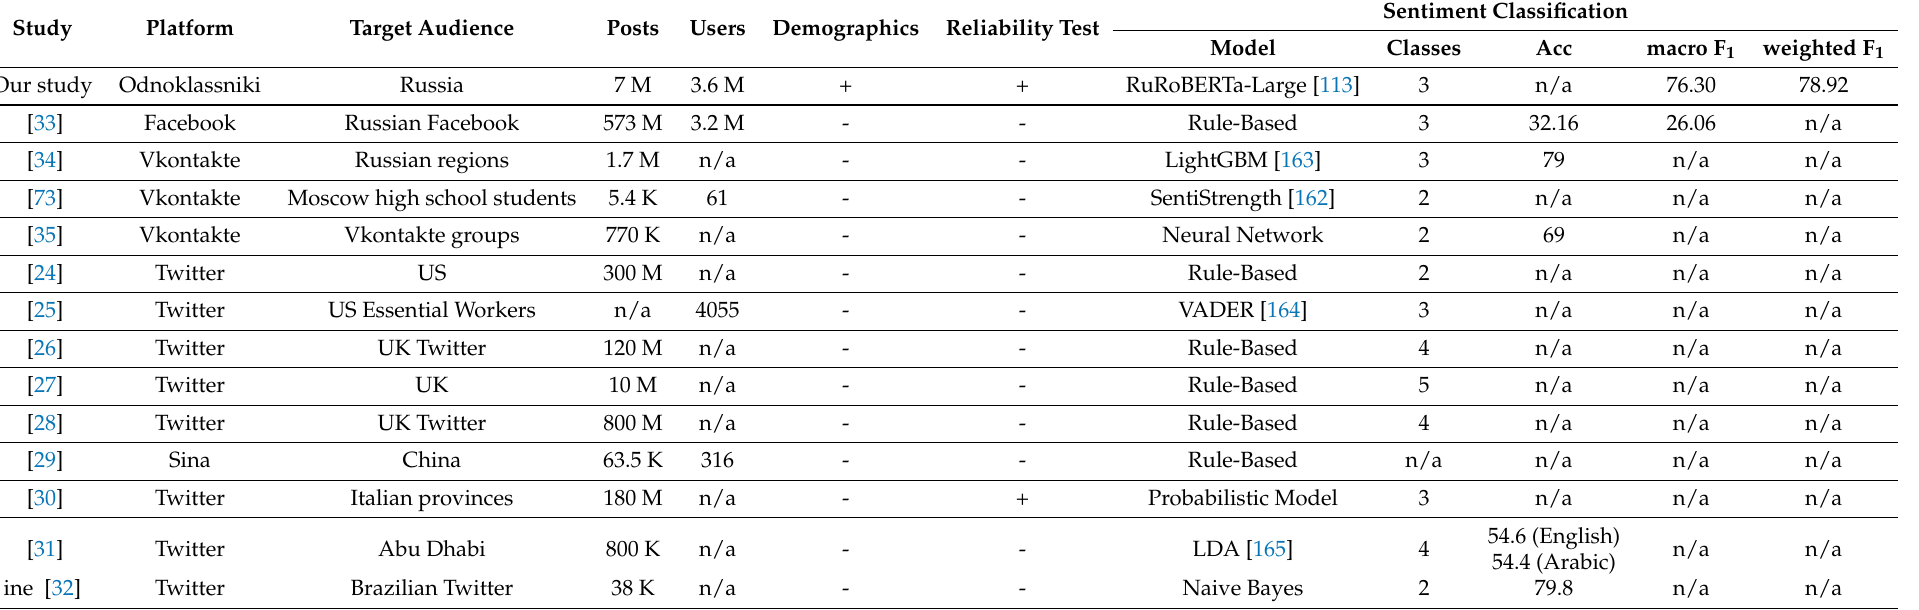
Table 4. OSWB studies. Panchenko [33] used a dictionary-based approach for sentiment analysis of Facebook posts but tested it on Books, Movies, and Cam- eras subsets of ROMIP 2012 dataset; we reported average score for these subsets. Sivak and Smirnov [73] used SentiStrength [162] but did not measure the classification